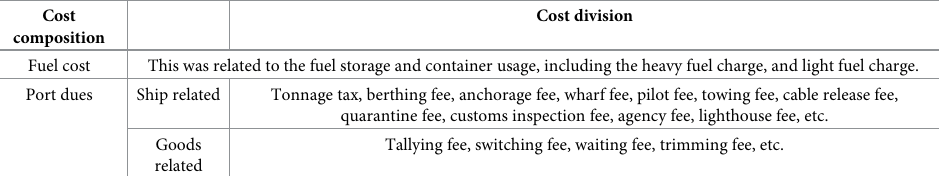
Table 1. Shipping variable cost